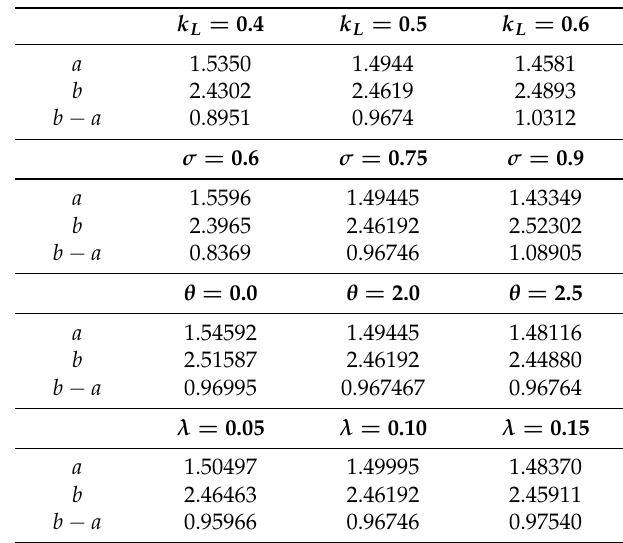
Table 1. Effects of k L , θ , σ , and λ on [ a , b ]